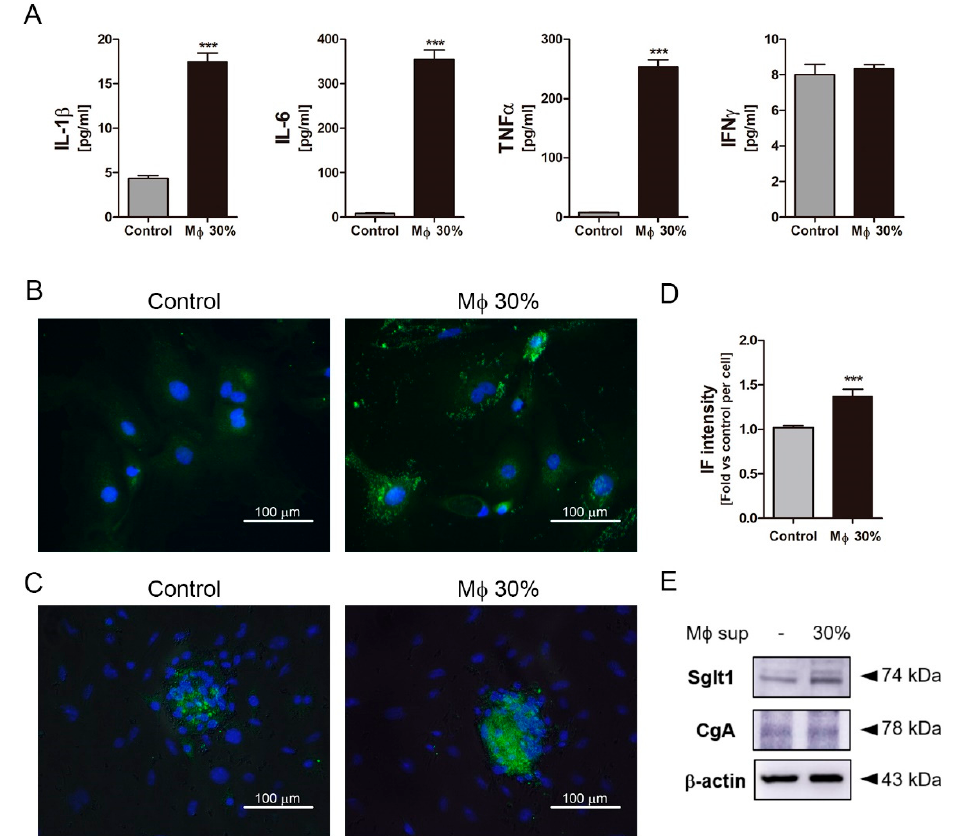
Figure 4. The inflammatory condition induced an increment of Na + -glucose co-transporter Sglt1 in isolated intestinal epithelium cells. Conditioned media (M φ 30%) containing inflammatory cytokines, such as IL-1 β , IL-6, TNF α , and IFN γ ( A ). IFN γ did not show significant difference. Isolated intestinal epithelium cells (IECs) were incubated without M φ 30% (Control, using a supernatant of non-activated RAW264.7 cells) or with conditioned media (M φ 30%) for two days. Following incubation with ( C ). Scale bars represent 100 µ m. Intensity of Sglt1 fluorescence elevated with incubation of M φ 30% ( D ). The protein expression levels of Sglt1 and Chromogranin A (CgA) in isolated IECs ( E ). *** p < 0.001, n = 5–6 / group, Student’s t